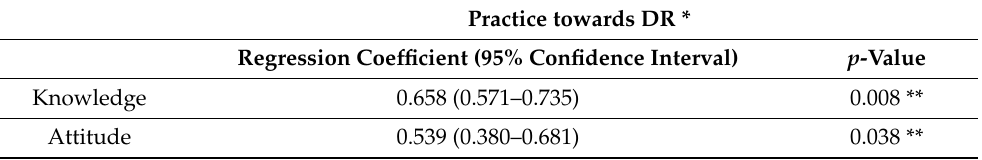
Table 5. Association between the knowledge, attitude, and practice towards DR assessed by a multilinear regression (adjusted for other